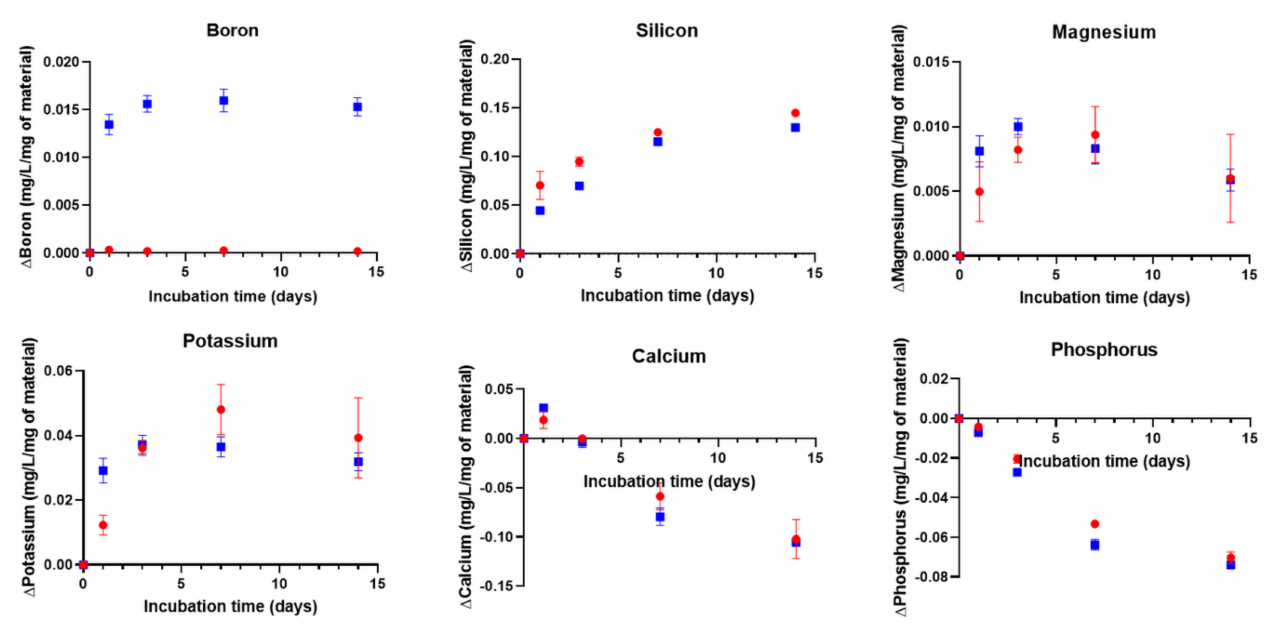
Figure 6. Concentrations of Si, Mg, K, P, Ca, and B in the dissolution products of G*/13-93 ( • ) and G*/13-93B20 ( (cid:4) ) immersed in Simulated Body Fluid (SBF) as a function of time. The concentrations are normalized to the sample mass. ∆ Element = [Element] in SBF in the presence of the sample – [Element] in SBF initial